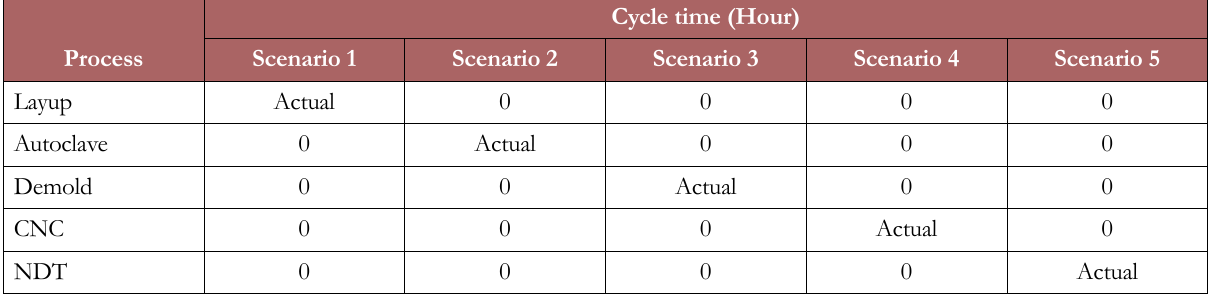
Table 3. Variation in cycle time as the experimental factor in determining difference in throughput of each process